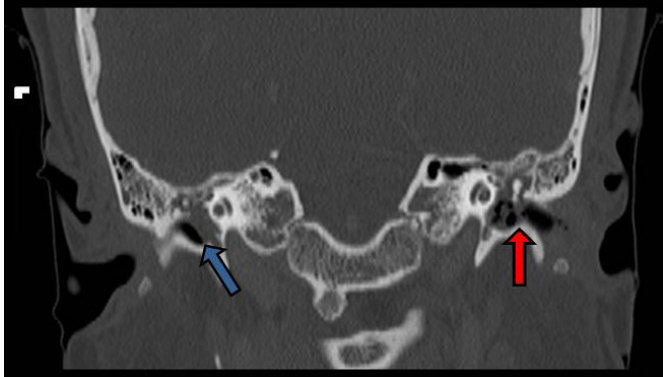
Image 2. Coronal computed tomography of the mastoid demonstrates an intact right tympanic membrane with fluid in the middle ear (blue arrow). The left external auditory canal is filled with bubbly fluid, which communicated directly with the left middle ear due to a ruptured tympanic membrane (red